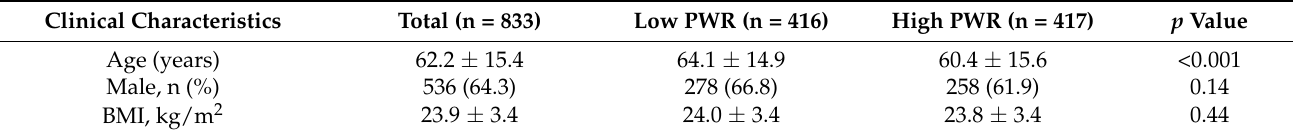
Table 1. Baseline characteristics of patients with liver abscesses according to the platelet